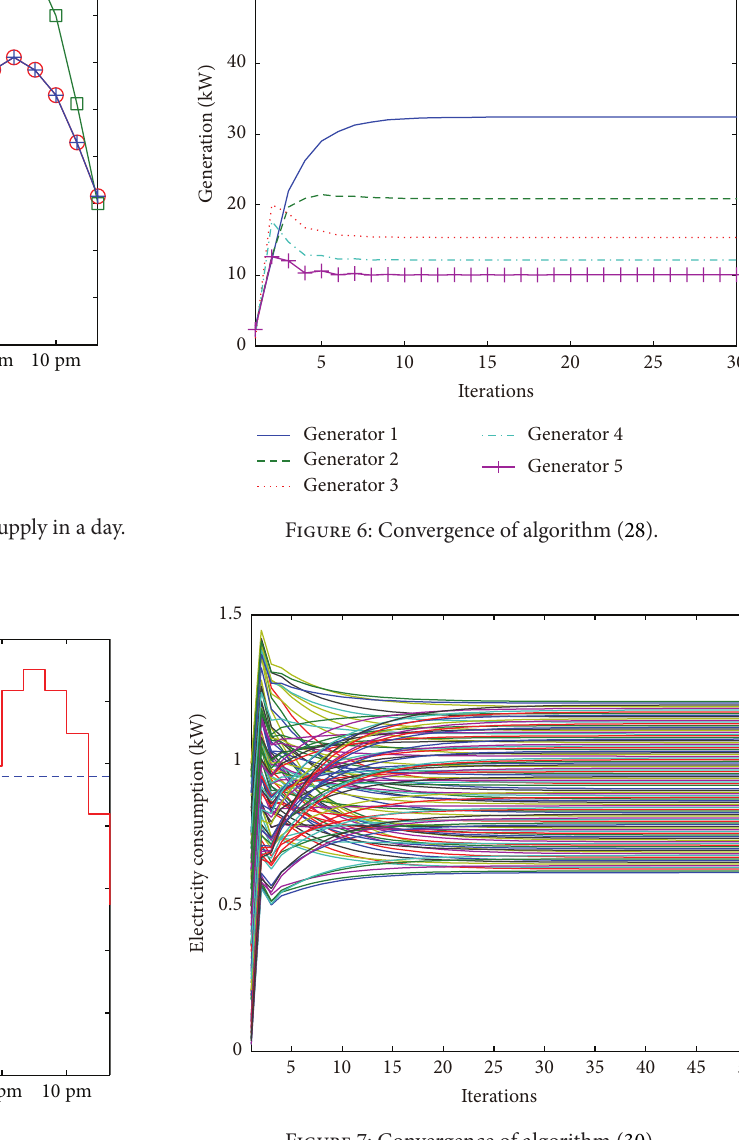
Figure 7: Convergence of algorithm